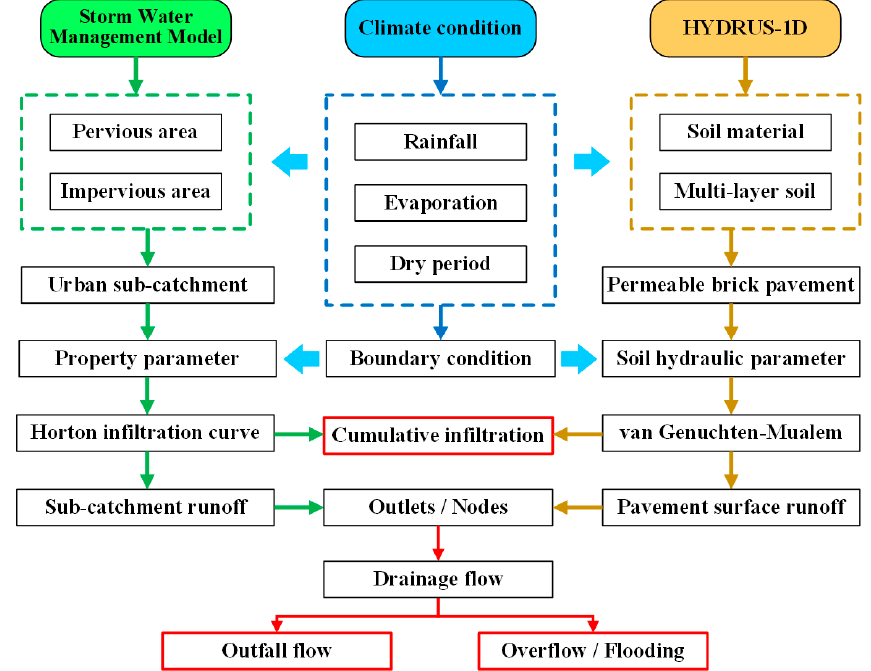
Figure 2. Schematic representation of the coupled model